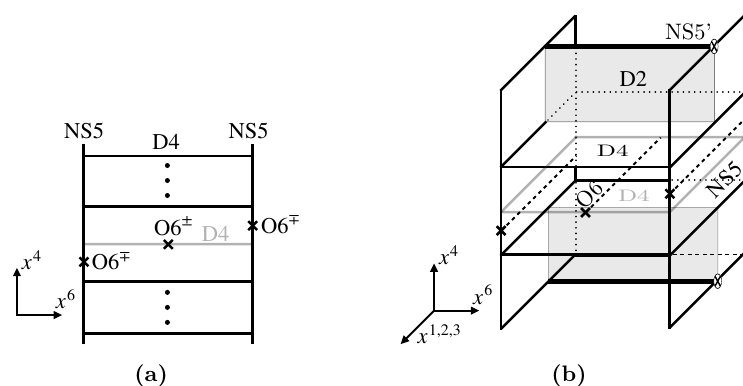
Figure 6. (a): a brane construction of the SO / USp N = 2 ∗ theory with an O6-plane. The (half) D4-brane on top of the O6-plane is present only when the gauge group is SO(2 n + 1) . (b): a realization of the ’t Hooft operator corresponding to the fundamental representation V and B = e n